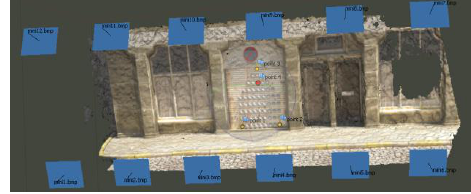
Figure 11. 3D model generation with control